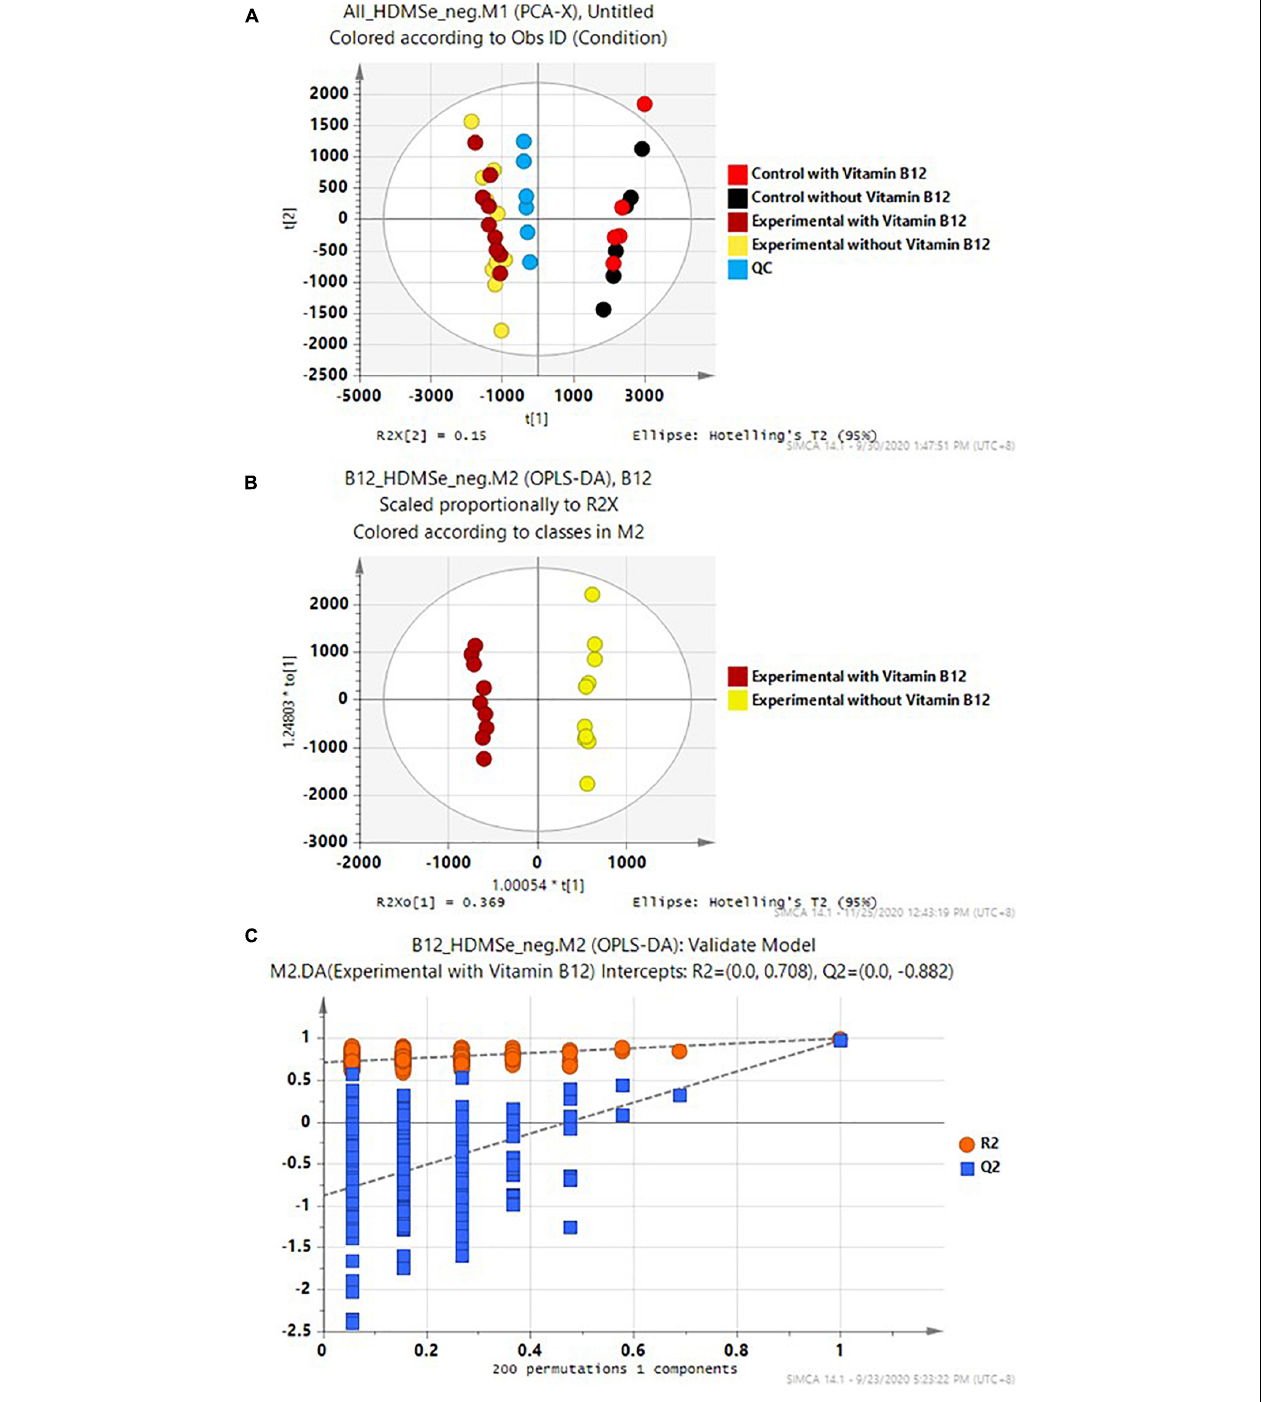
FIGURE 5 | (A) PCA of the whole data set, (B) OPLS-DA of the experimental media with and without supplement of Vitamin B 12 , and (C) 200 permutation tests of the OPLS-DA model in (B) .